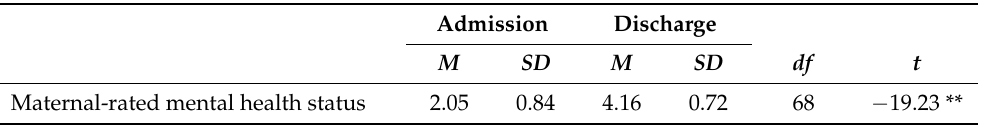
Table 2. Paired Samples t -Test Between Maternal-Rated Mental Health Status at Admission and Discharge with 1 = Extremely Unwell and 5 = Very